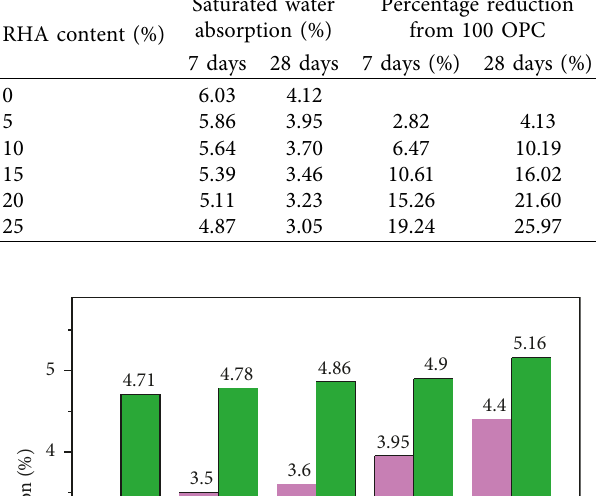
Figure 25: % loss in compressive strength of banana leaves’ ashes with HCl and MgSO 4 . [37].